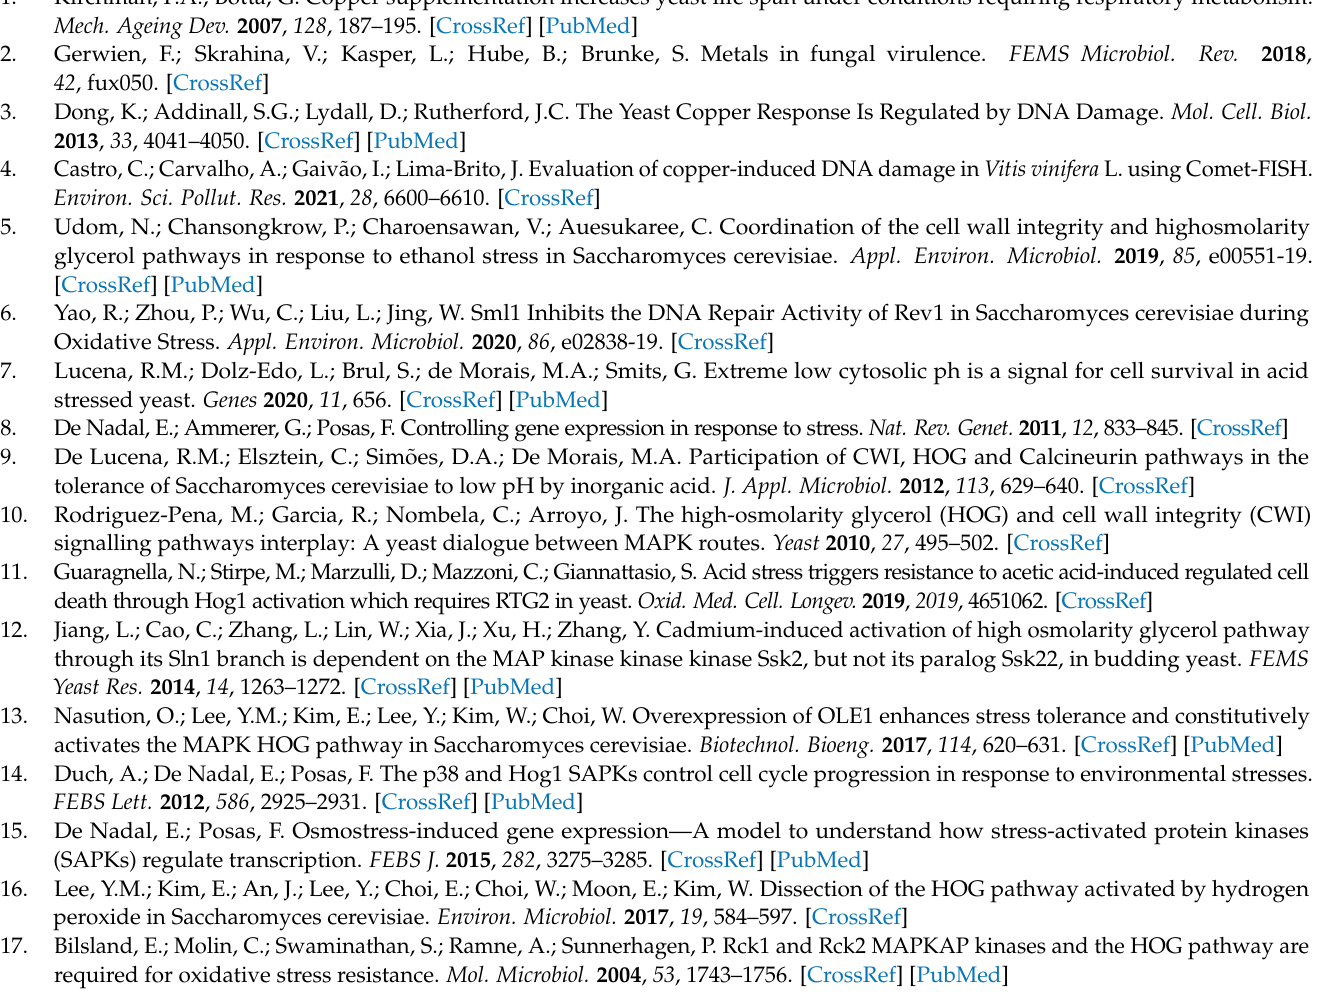
Table S2: Primers used in this study for RT-qPCR